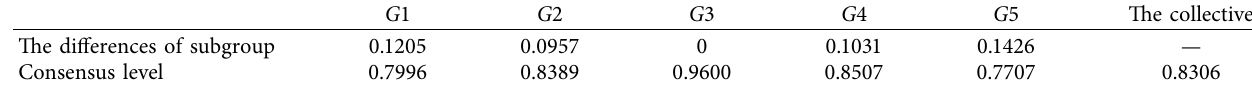
Table 16: .e consensus level without considering the adjustment willingness.